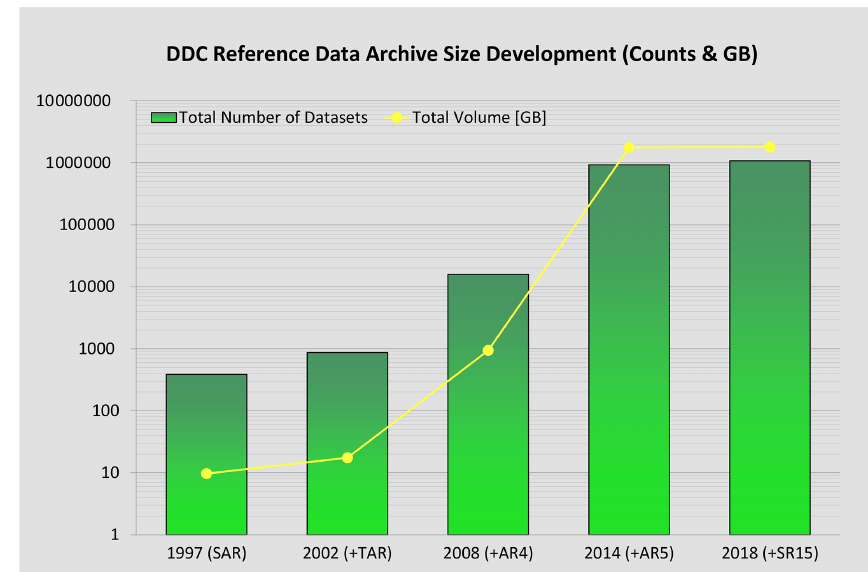
Figure 3. Size development of the DDC Reference Data Archive for the global climate model data.